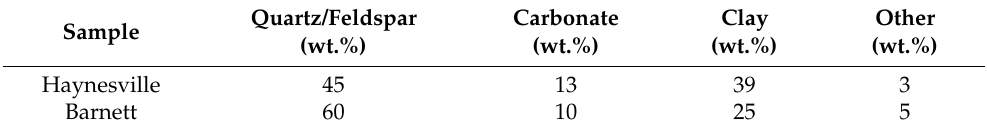
Table 5. Mineral contents of the shale samples